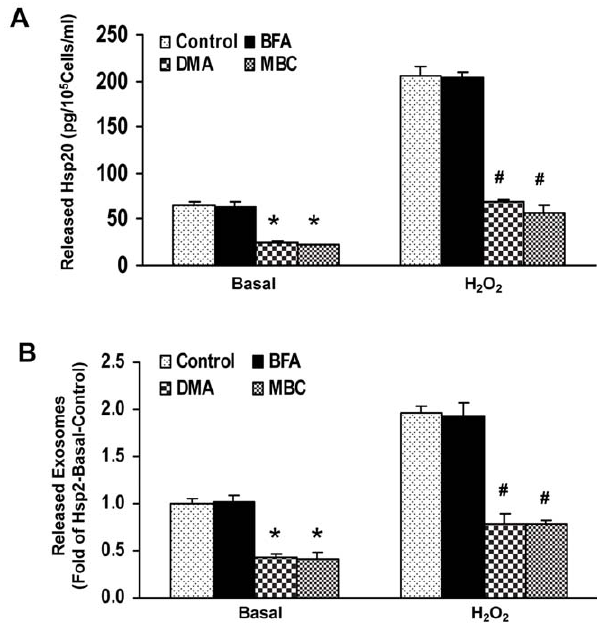
Figure 3. Hsp20 is secreted from adult rat cardiomyocytes via exosomes, independent of the ER-Golgi protein export path- way. (A) Brefeldin A (BFA), which inhibits the classical protein transport pathway, did not block Hsp20 release into the media under either basal or hypoxia conditions (20 m M H 2 O 2 ). However, the release of Hsp20 from cardiomyocytes was reduced by both dimethyl amiloride (DMA), an exosome inhibitor, and Methyl- b -cyclodextrin (MBC), an inhibitor of lipid raft formation via depletion of membrane cholesterol. (B) The activity of acetylcholine esterase was used to quantify the amount of exosomes present in the media after various treatments. Similar results were observed in three additional, independent experiments (*, p , 0.05 vs. Basal-Control; # , p , 0.05 vs. H 2 O 2